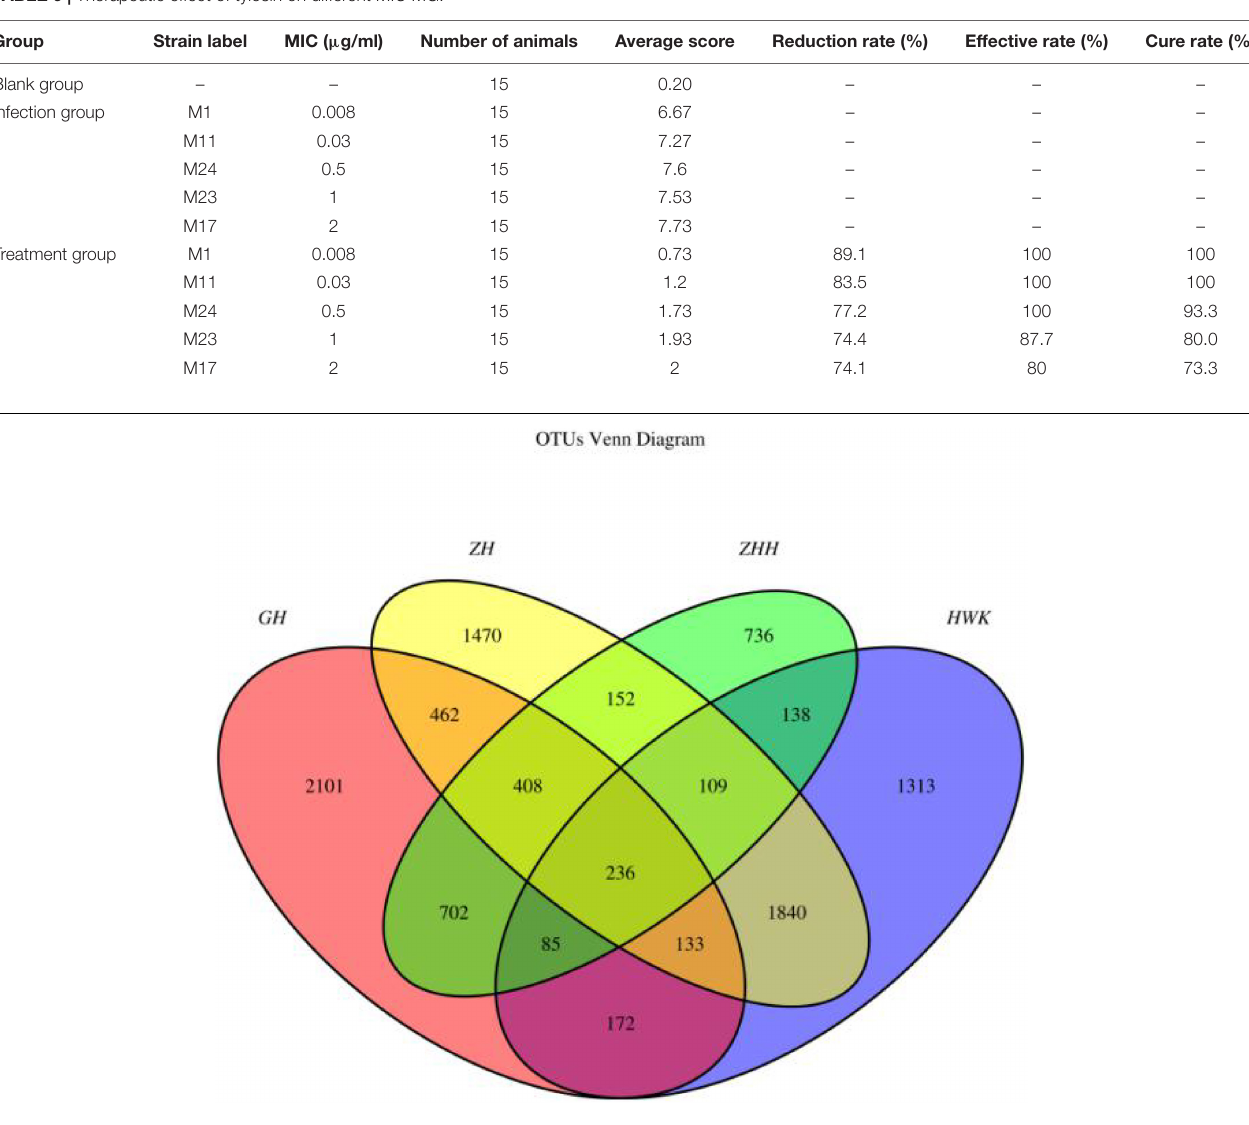
FIGURE 10 | Venn diagrams of the core and unique OTUs of the four groups. HWK (control group); GH (infection group); ZH (treatment group); ZHH (post-treatment group).